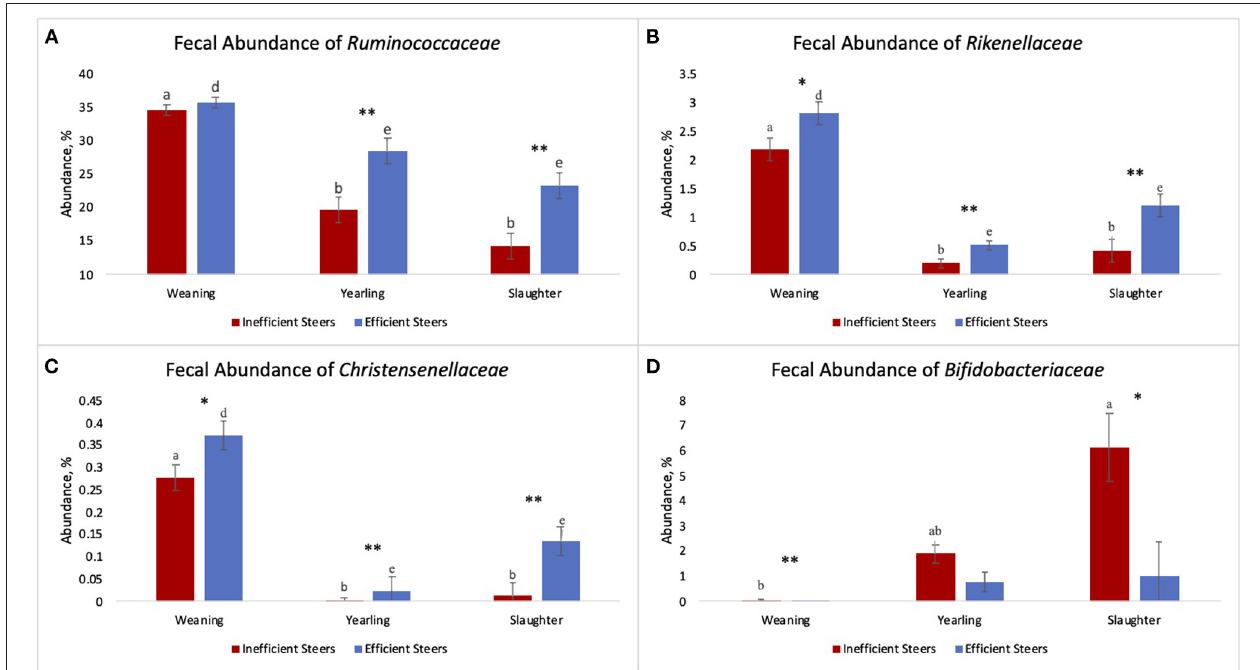
FIGURE 5 | Fecal abundance of Ruminococcaceae (A) , Rikenellaceae (B) , Christensenellaceae (C) , and Bifidobacteriaceae (D) at weaning, yearling, and slaughter of inefficient ( n = 8) and efficient ( n = 7) steers. a,b,c indicate a significant difference across timepoints ( P ≤ 0.05) of inefficient steers. d,e,f indicate a significant difference across timepoints ( P ≤ 0.05) of efficient steers. Asterisks indicate a difference between inefficient and efficient steers at individual timepoint with * indicating a trend (0.10 ≤ P ≥ 0.05) and ** indicating a significant difference ( P ≤ 0.05). Error bars indicate standard error.